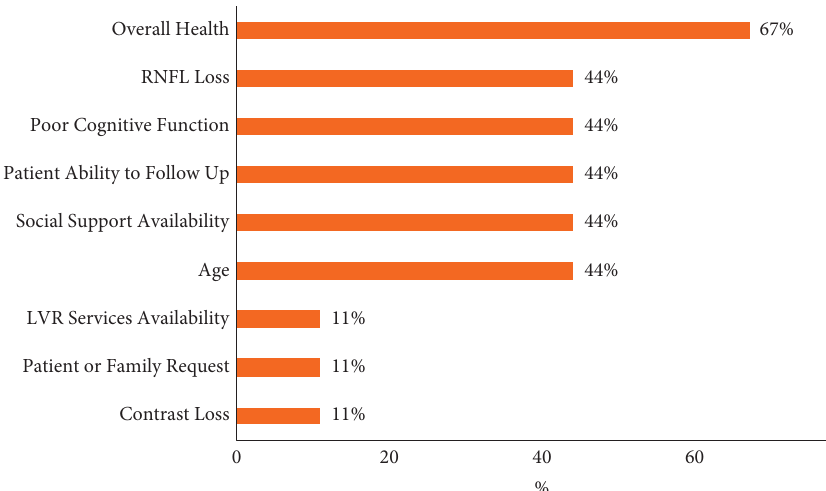
Figure 3: Barriers to low-vision rehabilitation services from online survey evaluating eye care provider referral practices. LVR � low-vision rehabilitation; RNFL � retinal nerve fiber layer.